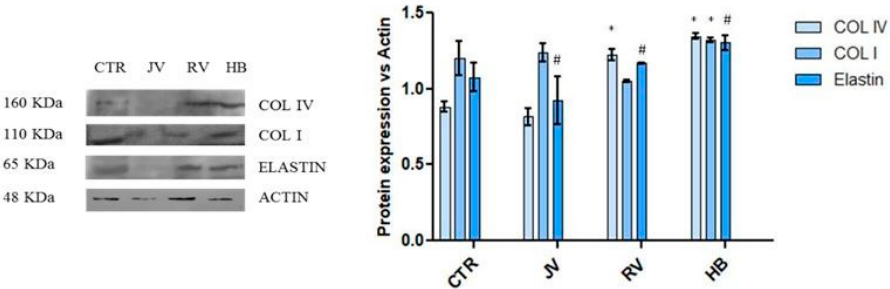
Figure 8. Western blotting for expression of collagen I, collagen IV and Elastin normalized to actin in the densitometry reported as average and SD. * stands for significant ( p < 0.05) variations respect to CTR, # stands for p < 0.05 for elastin expression in HB treatment vs. R V and J V ones.